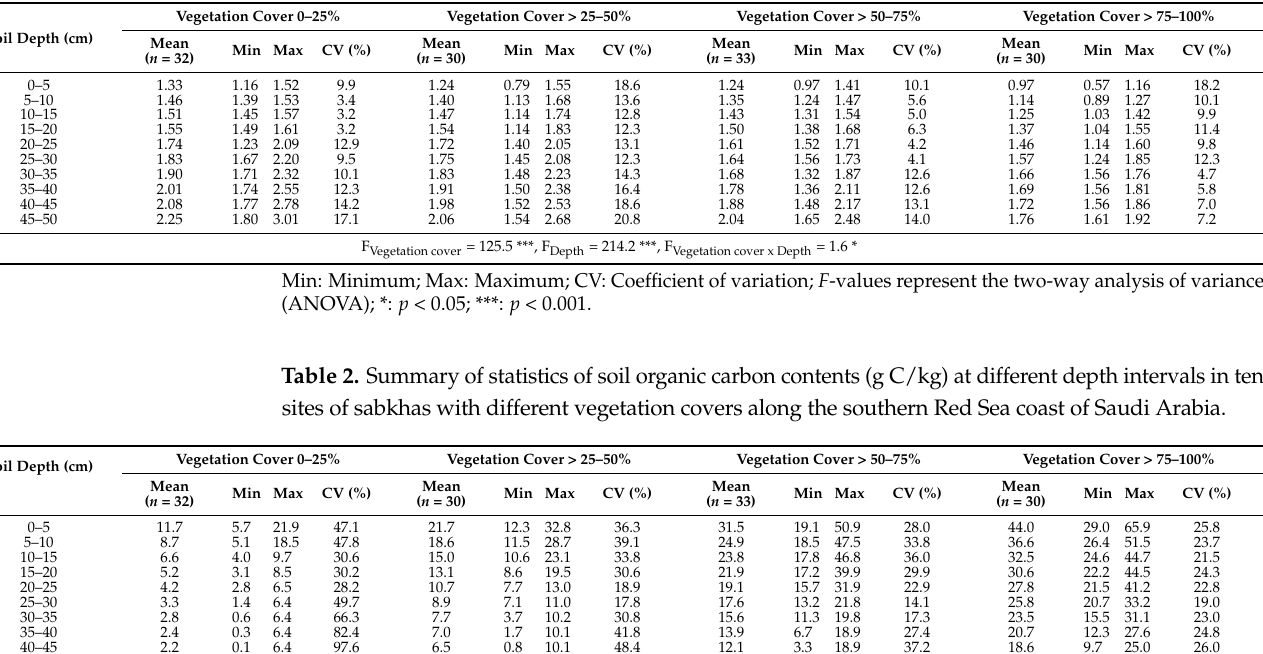
Table 1. Summary of statistics of soil bulk density (g/cm 3 ) at different depth intervals in ten sites of sabkhas with different vegetation covers along the southern Red Sea coast of Saudi Arabia.